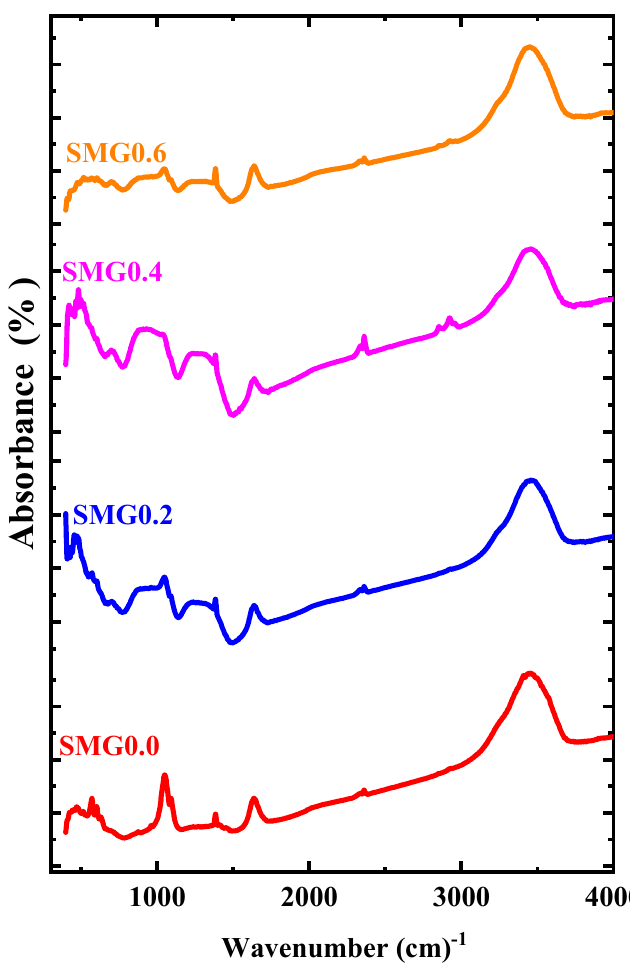
Figure 3. FTIR spectra of glass samples.